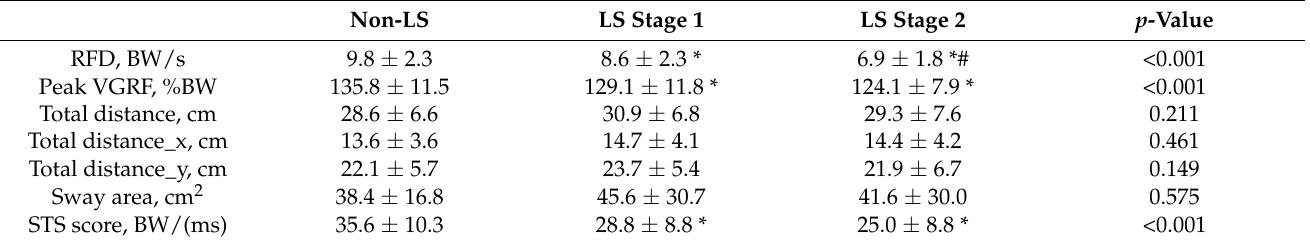
Table 2. STS variables for each LS group.